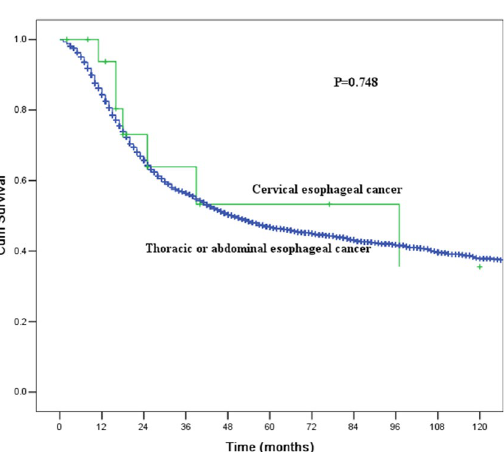
Figure 4. Comparisons of the survival curves for patients with cervical oesophageal cancer and patients with thoracic or abdominal oesophageal cancer who did not receive preoperative therapy. The MST and the1-, 3-, and 5-year OS rates for CEC patients were 97.0 months (95% CI 10.0–184.0 months), 93.8%, 63.9%, and 53.3%, respectively, compared with those of 50.0 months (95% CI 44.1–55.9 months), 84.3%, 56.5%, and 46.8% for patients with thoracic or abdominal oesophageal cancer. The survival differences were not significant (P =